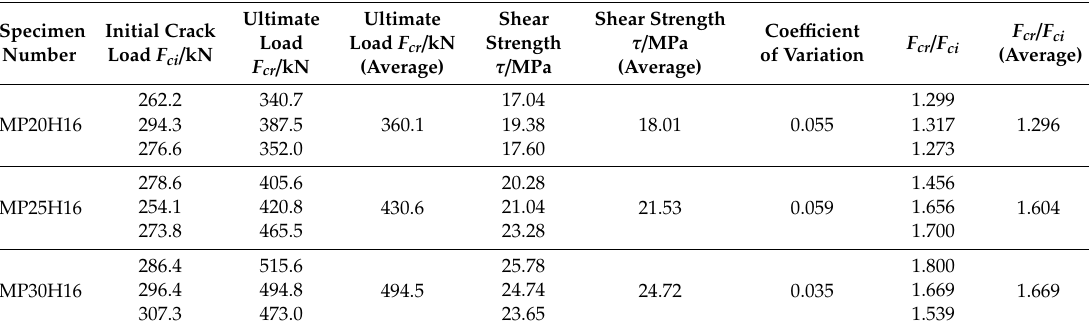
Table 5. Direct shear test results of the MPSs.